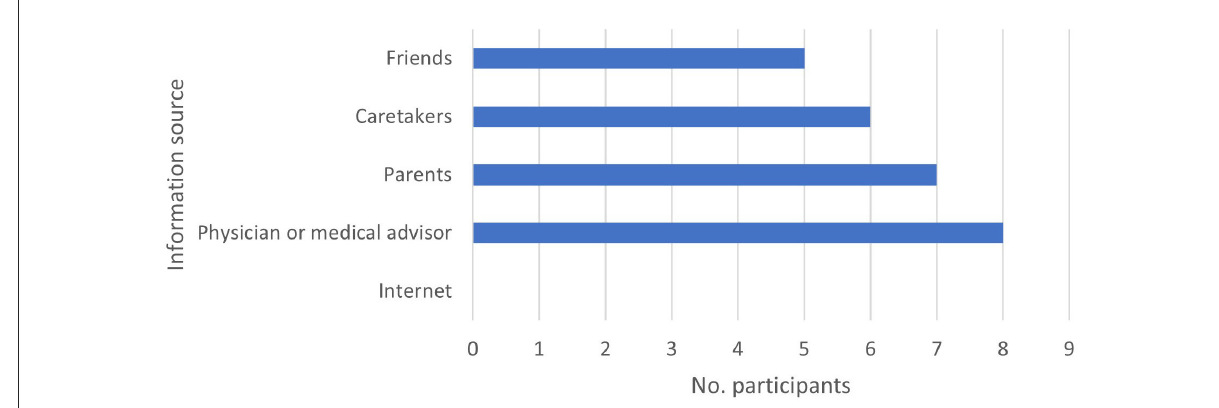
FIGURE1 Source of health information of participants with mild to moderate intellectual disabilities.